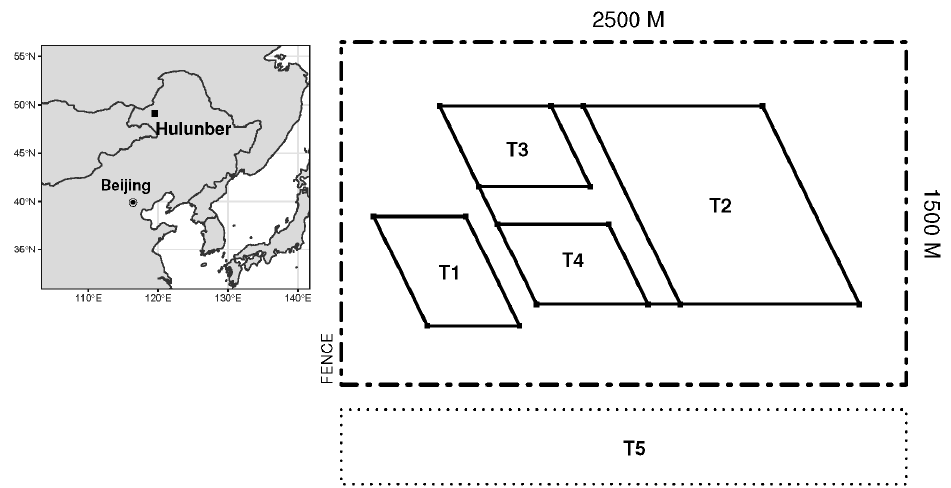
Figure 6. The study area and the plot arrangement in the field experiment in Hulunber. Plots T1 through T4 are located in a fence-enclosed field of 1500 m by 2500 m in size. Plot T5 is located on the open grassland outside the enclosure.